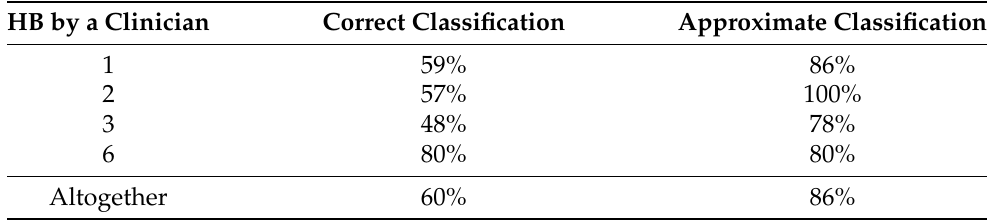
Table 11. Accuracy of classification by OLR